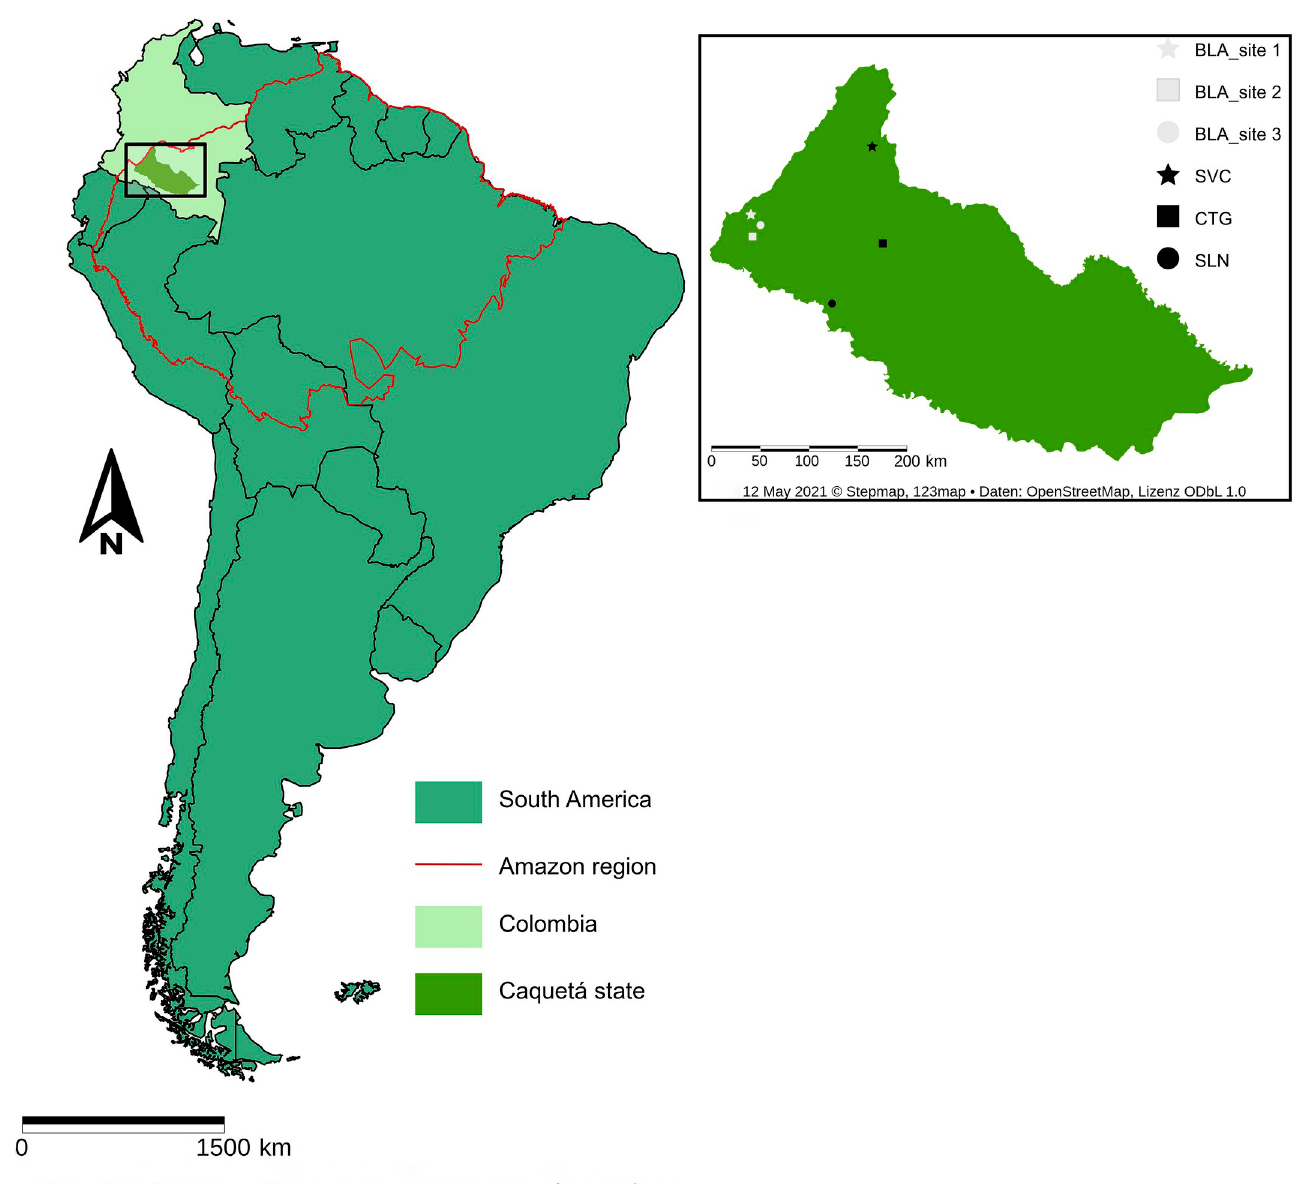
Fig 1. The geographic location of the study sites in the northwestern region of Colombian Amazon (BLA: Bele´n de los Andaquı´es, SVC: San Vicente del Cagua´n, CTG: Cartagena del Chaira´, SLN: Solano). Republished from StepMap.com under a CC BY license, with permission from StepMap GmbH, original copyright